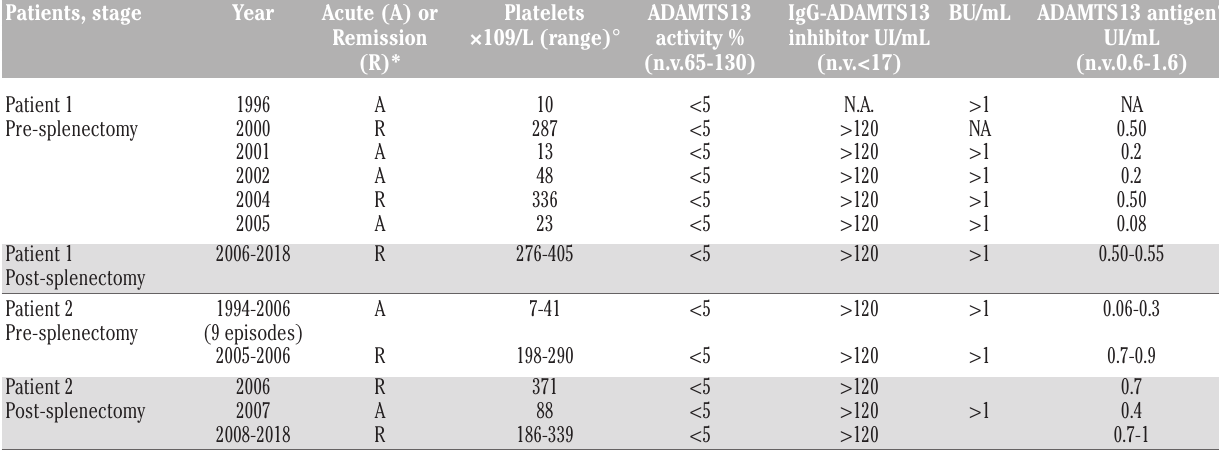
Table 1. Laboratory values at different timepoints of the